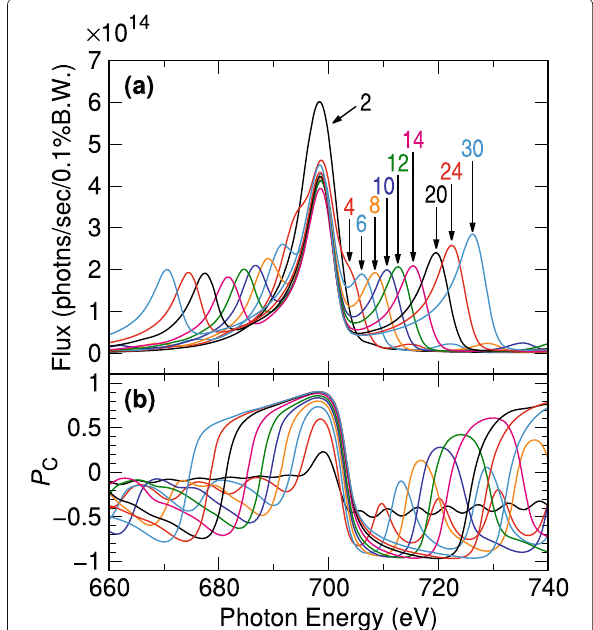
Fig. 4 Segmentation effect of SCU. a Energy spectra and b degree of CP, P C calculated by SPECTRA for the different combinations of M and N . The number of segments, M are indicated in a high-energy side. The number of segments will be deter- mined by considering the decrease in brilliance due to the drift space and the increase in P C due to larger number of segments. In this case, 8, 10, or 12 segments would be reasonable.